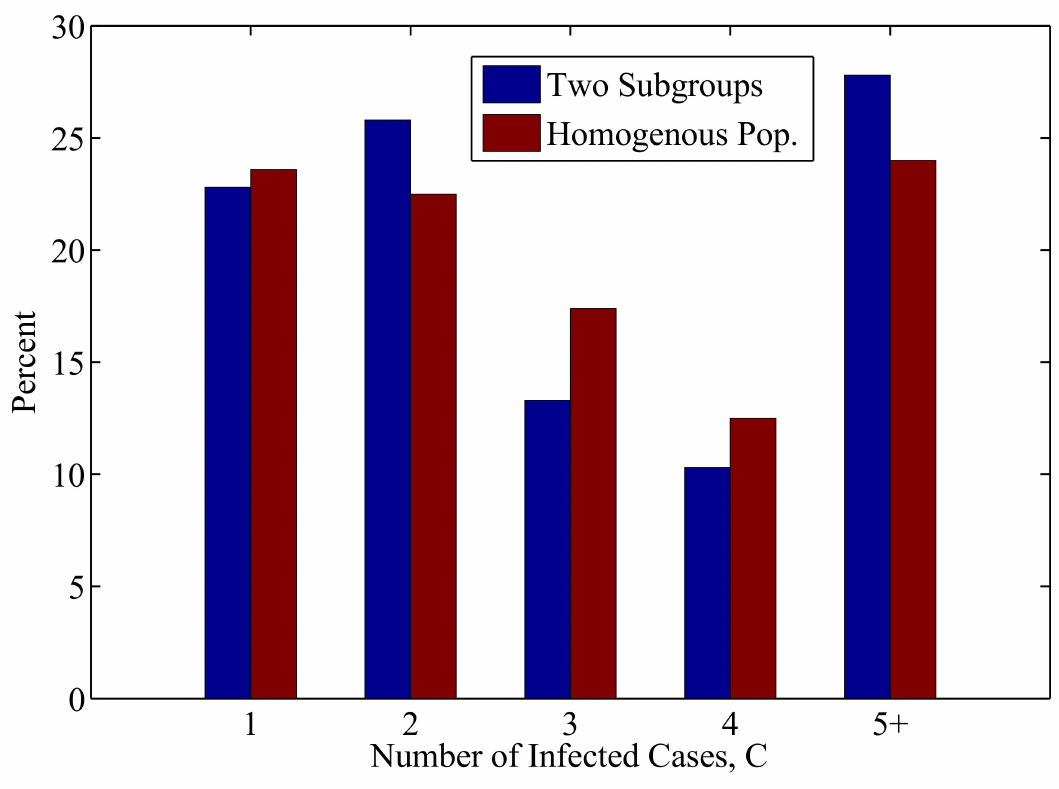
Figure 2. Histogram of the total number of infected cases in a homogenous population of 1000 or a population with two subgroups each of 500 individuals. There were 1000